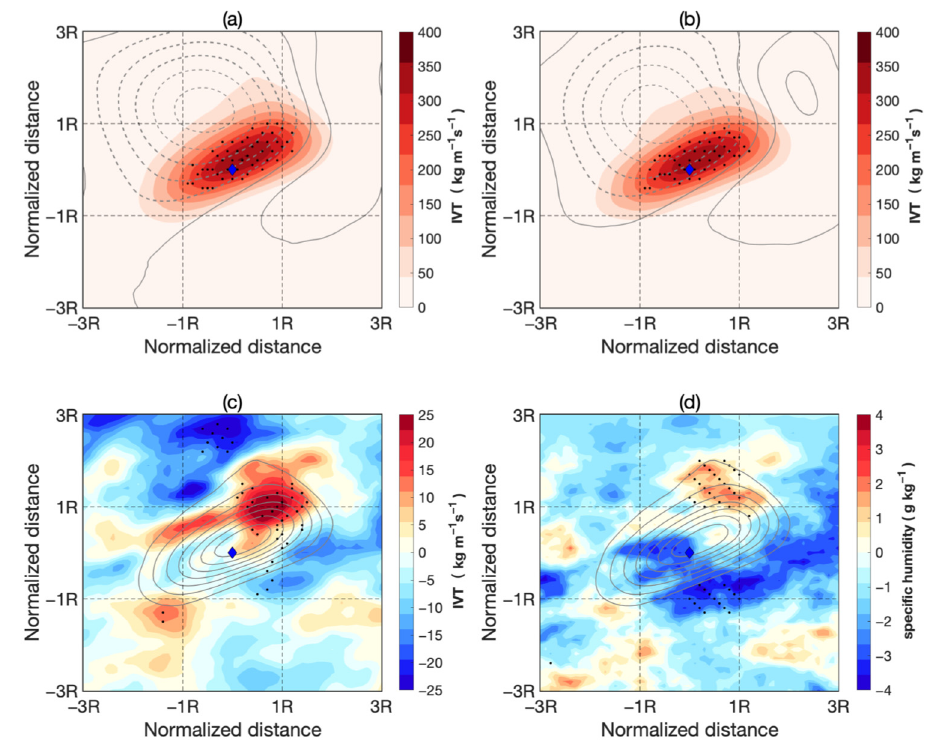
Figure 8. ( a ) Composite of IVT (color, kg m − 1 s − 1 ) and SLP anomalies (contours in interval of 1 hpa) in ARs during NAT+ phase. ( b ) Same as ( a ) but for NAT − phase. ( c ) Difference in IVT (color) between NAT+ and NAT − phases. Contours are IVT in NAT+ phase from 50 to 350 with the interval of 50 kg m − 1 s − 1 . Black dots mark those above 95% confidence level based on a Student’s t -test. ( d ) Same as ( c ) but for specific humidity on 850 hPa (g kg − 1 ). The blue diamond in each sub-figure marks the center of the domain. R on the axes is the normalized length of ARs. The range of AR length is shown in Figure 4d. The length of more than 60% of ARs is within 40 degrees (which is about 4000